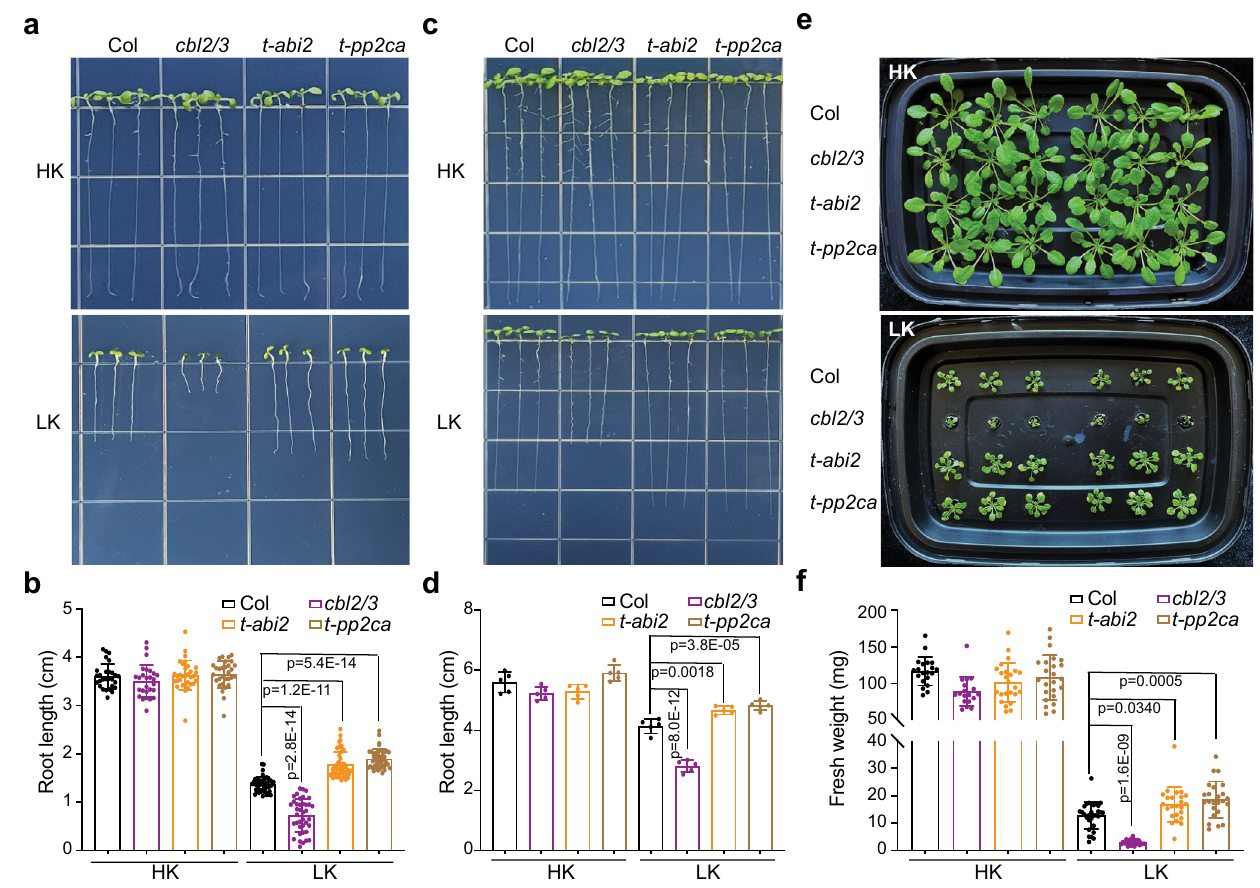
Fig. 5 | hab1abi1pp2ca and hab1abi1abi2 triple mutants show tolerant pheno- type under low-K + stress. a Seed germination of wild type (Col-0), cbl2/3 double mutant, hab1abi1pp2ca and hab1abi1abi2 triple mutants under high- and low-K + conditions. Representative images show 7-day-old seedlings after direct germina- tion on the medium containing high-K + (20mM) condition or low-K + (5 μ M) con- dition. ( b ) Measurement of root length at the end of the assay as shown in ( a ). c Representative images of wild type (Col), cbl2/3 double mutant, hab1abi1pp2ca and hab1abi1abi2 triple mutants under high- or low-K + in post-germination assays. The seedlings were grown under suf fi cient-K + (20mM) condition for 4 days, fol- lowed by a transfer to high-K + (20mM) or low-K + (5 μ M) conditions and grown for